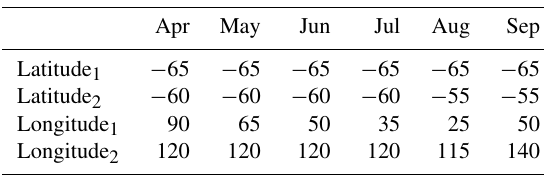
Table 4. Monthly latitude/longitude corners used for assessment of sea ice conditions on snow petrel breeding success. These areas were defined from the distribution of snow petrels recorded from miniaturized saltwater immersion geolocators during winter (De- lord et al.,